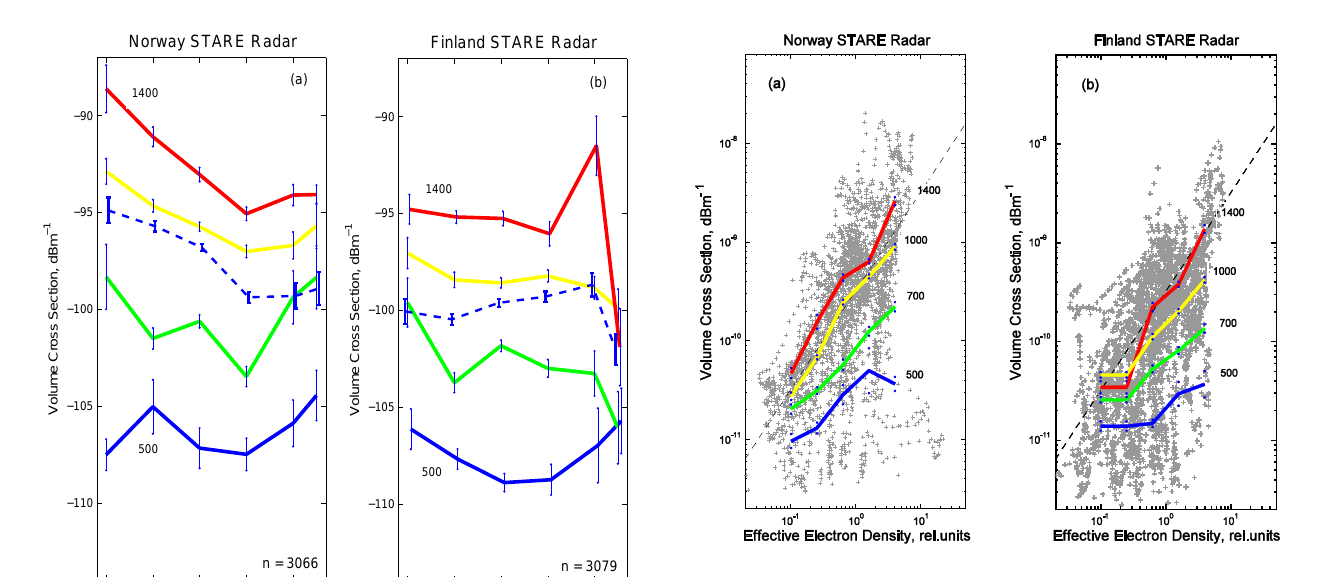
Fig. 5. (a) The Norway and (b) Finland radar VCSs dependence upon the effective electron density for various mean electron drift velocities. The measured VCSs were grouped in five equal electron density bins and averaged over four intervals of the electron drift velocity centred at 500, 700, 1000 and 1400ms − 1 , blue, green, yellow and red lines, respectively. Blue dots show the span of the error bars around each mean VCS